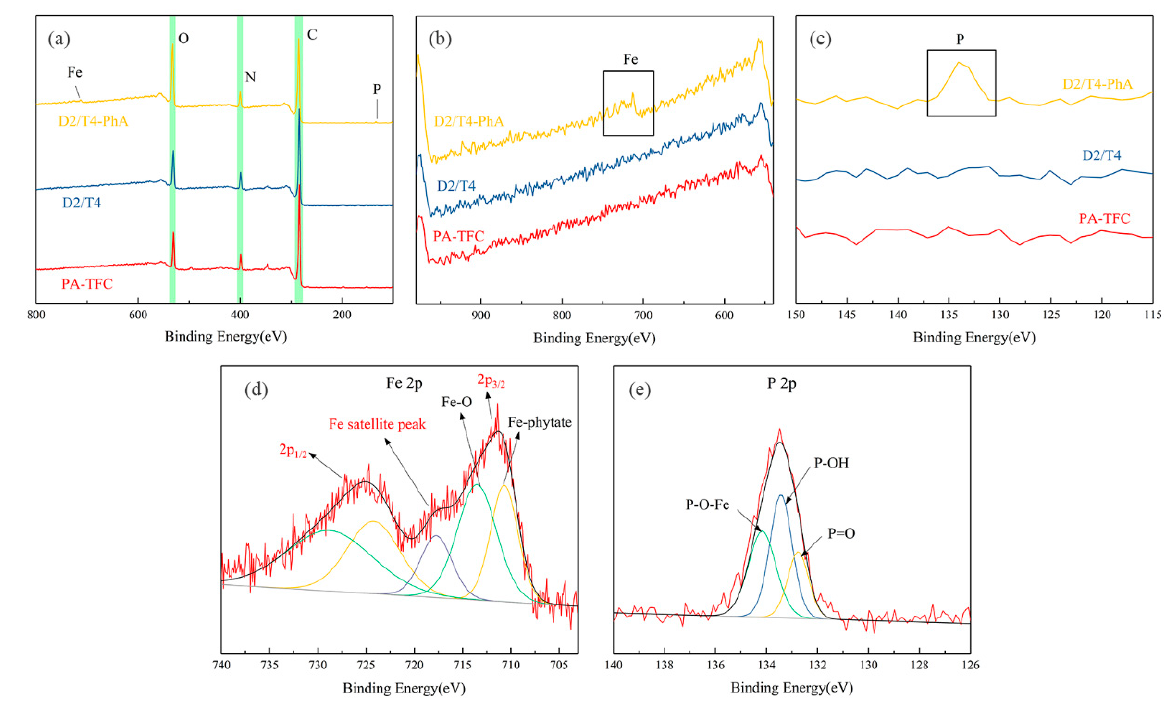
Figure 2. XPS spectra of the virgin and modified RO membranes on ( a ) 800–180 eV, ( b ) 980–540 eV, ( c ) 150–115 eV, and ( d ) Fe 2p or ( e ) P 2p XPS spectra of DA/TA-PhA membrane.